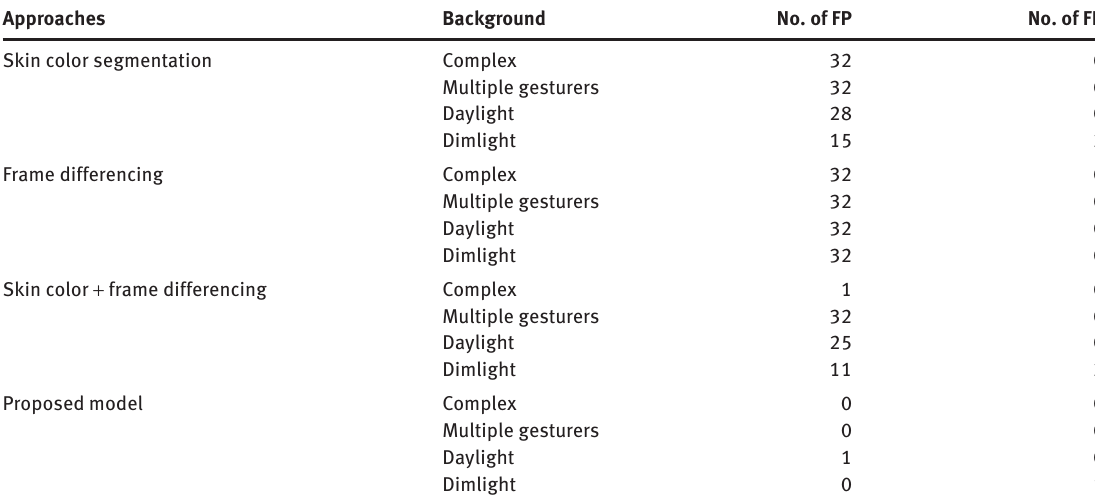
Table 1: Comparative Hand Segmentation Results. Approaches